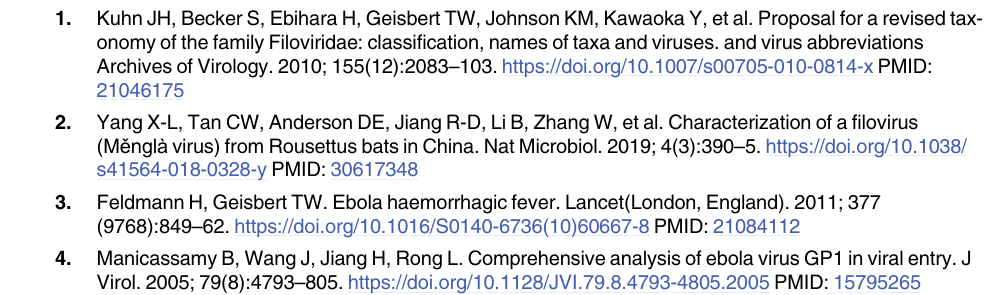
S1 Table. All compounds tested in Fig 2 had cytotoxicity values higher than the IC50 for the compounds pseudotyped wild-type Ebola virus, wild-type Marburg virus, and Ebola virus mutants Y517S proving these compounds inhibit viral entry. S2 Table. Mutations were made at various residues in two regions on interest (the Cap region and internal fusion loop region) of the MARV GP. Summary of the pseudotyped mutant virus infectivity and inhibition with Toremifene. The mutants in the cap region with % infectivity in brackets suggested there might be a shift in potency when tested with Toremifene at 10 uM. Full dose response curves were performed for these mutants and there was no change in potency. S3 Table. Mutations were made at various residues in the cap region of the EBOV GP. Summary of the pseudotyped mutant virus infectivity and inhibition with Toremifene. Full dose response curves were performed for these mutants and there was no change in